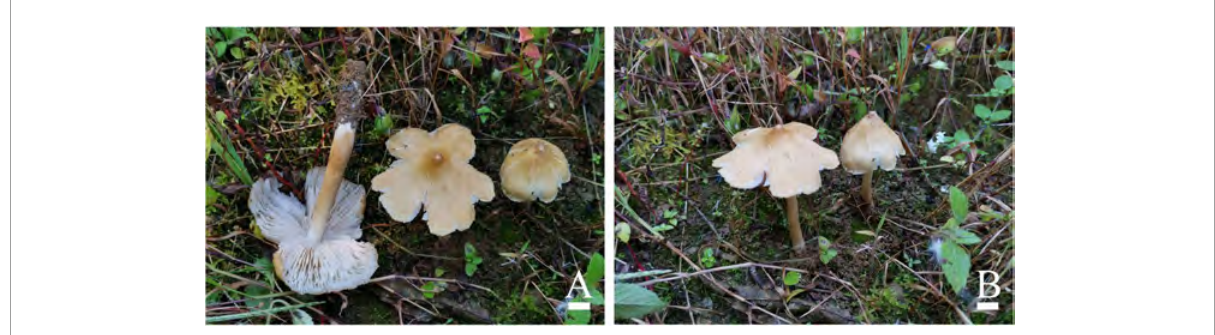
FIGURE2 Basidiomata of Inosperma nivalellum . (A,B) MHHNU31689, holotype. Scale bars = 10 mm.